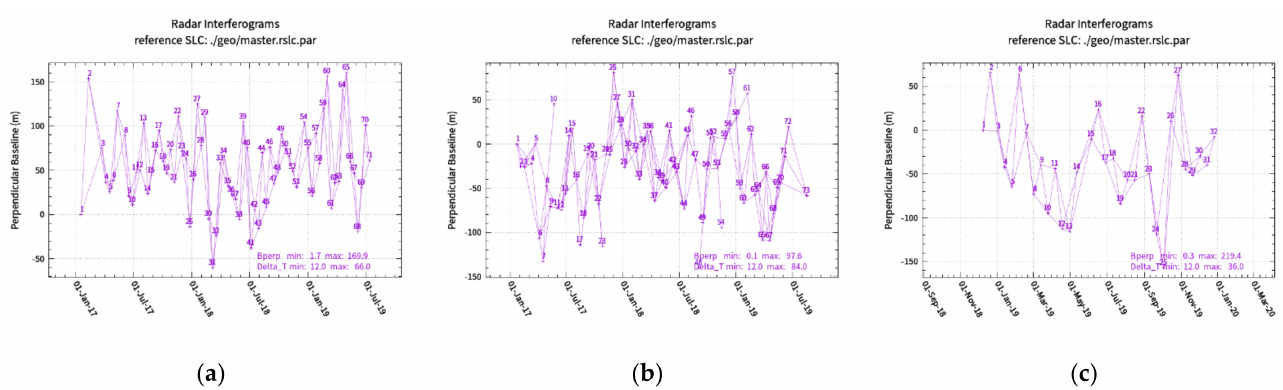
Figure A1. Spatiotemporal baseline network of ( a ) track 33, ( b ) track 26, and ( c ) track